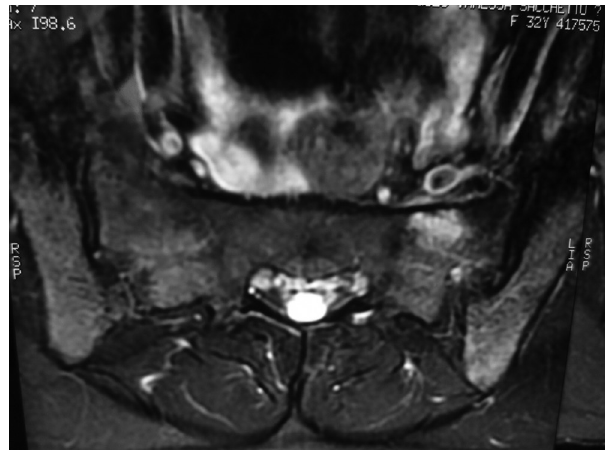
Figure 2 - A magnetic resonance image showing an area with a hypersignal suggestive of a sacral stress